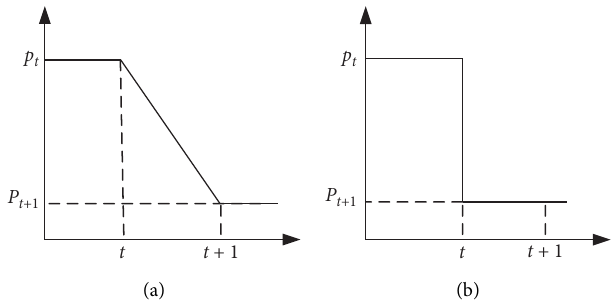
Figure 1: The two types of concept drift. (a) Gradual drift. (b) Abrupt drift.